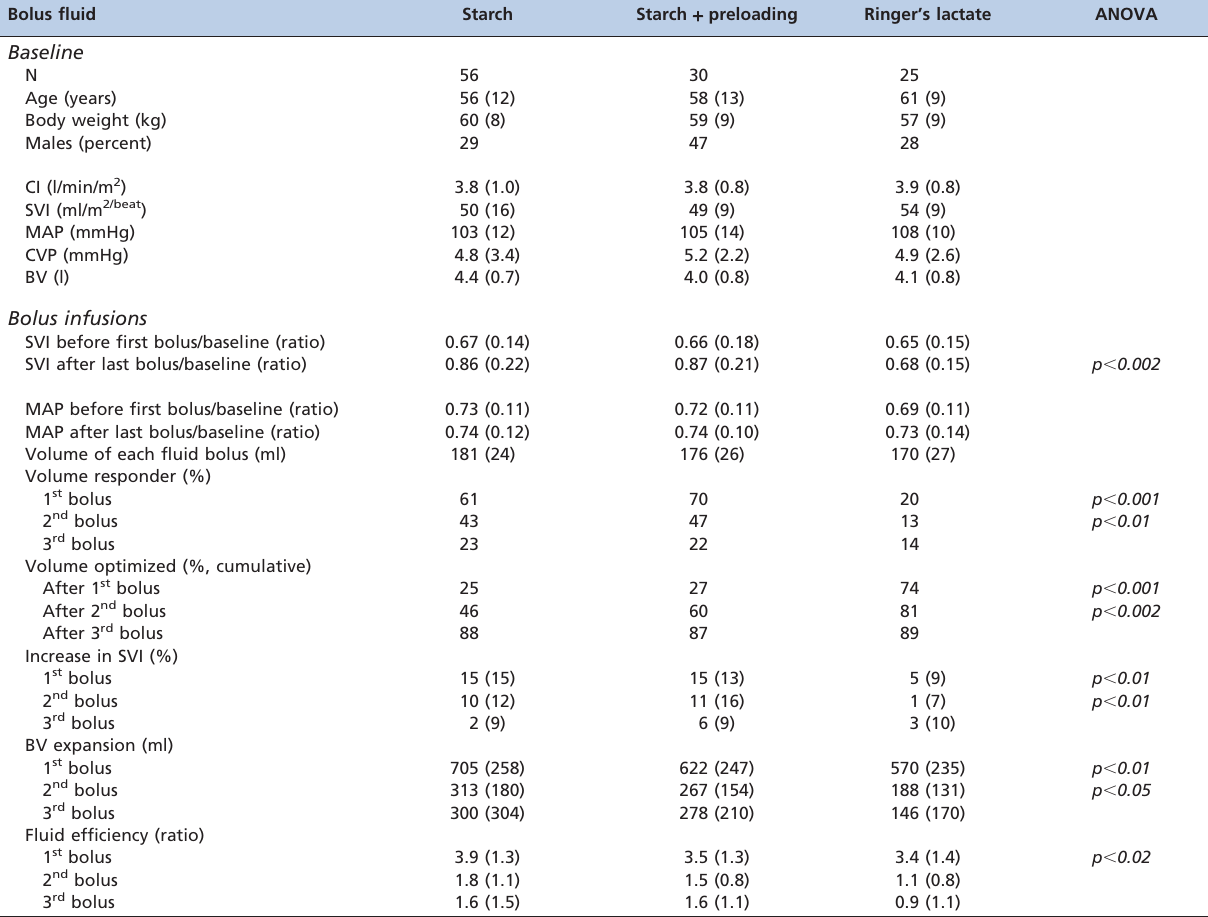
Table 1 - Demographics, hemodynamics and blood volume (BV) expansion. The data are presented according to the contents of the three successive bolus infusions: hydroxyethyl starch or Ringer’s lactate. Bolus